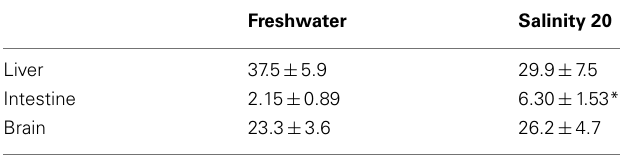
Table 4 |The amination activity ( μ mol NADH oxidized min − 1 g − 1 tissue) of glutamate dehydrogenase from the liver, intestine, and brain of Monopterus albus kept in freshwater (control) or in water at salinity 20 for 1day after a 3-day progressive increase in salinity from